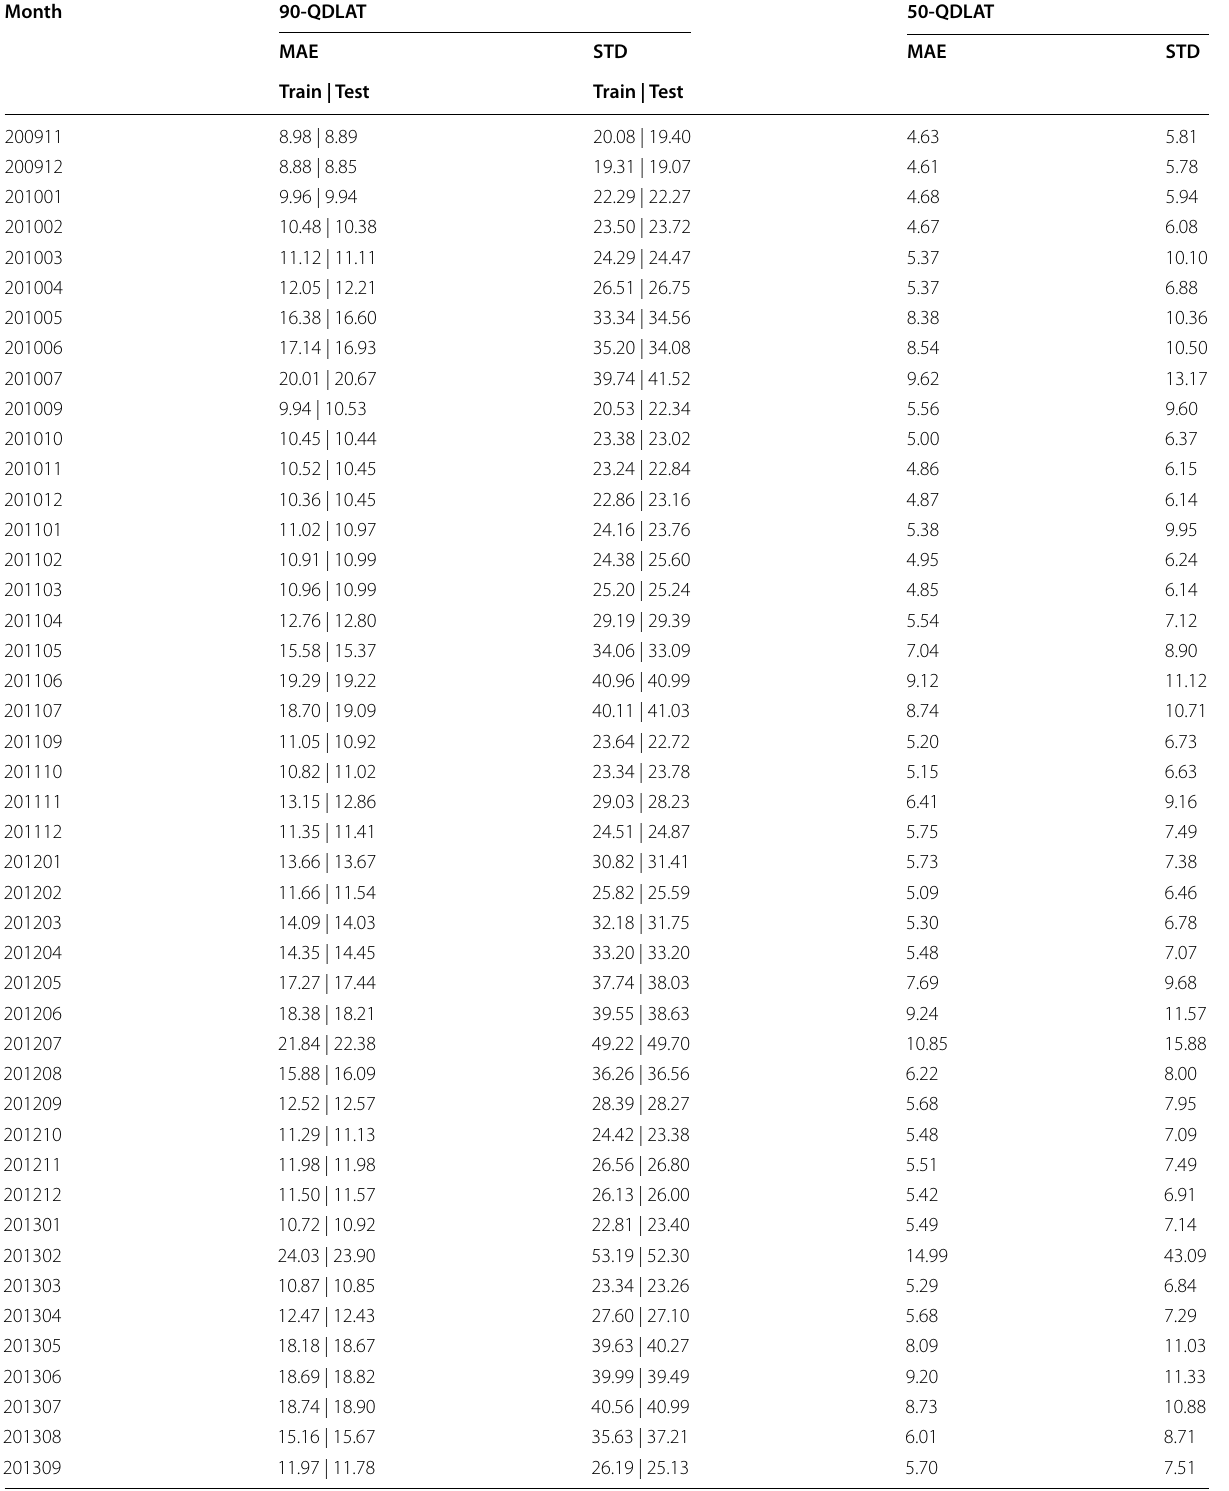
Table 2 Error values in nT after fine‑tuning training of the neural network for every month, on the left for the whole latitude region, on the right for low‑ and